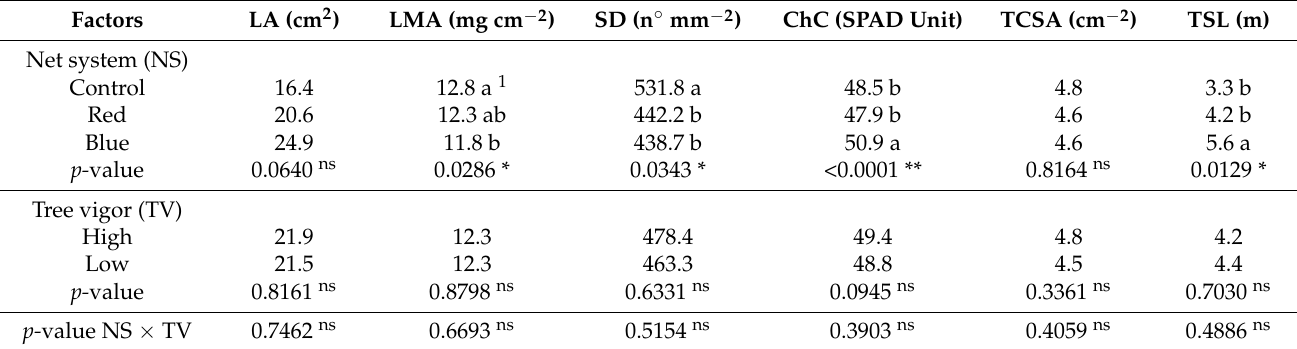
1 Mean separation within rows by the LSD Fischer test; n = 6 leaves. *; **; ns: Significant, highly